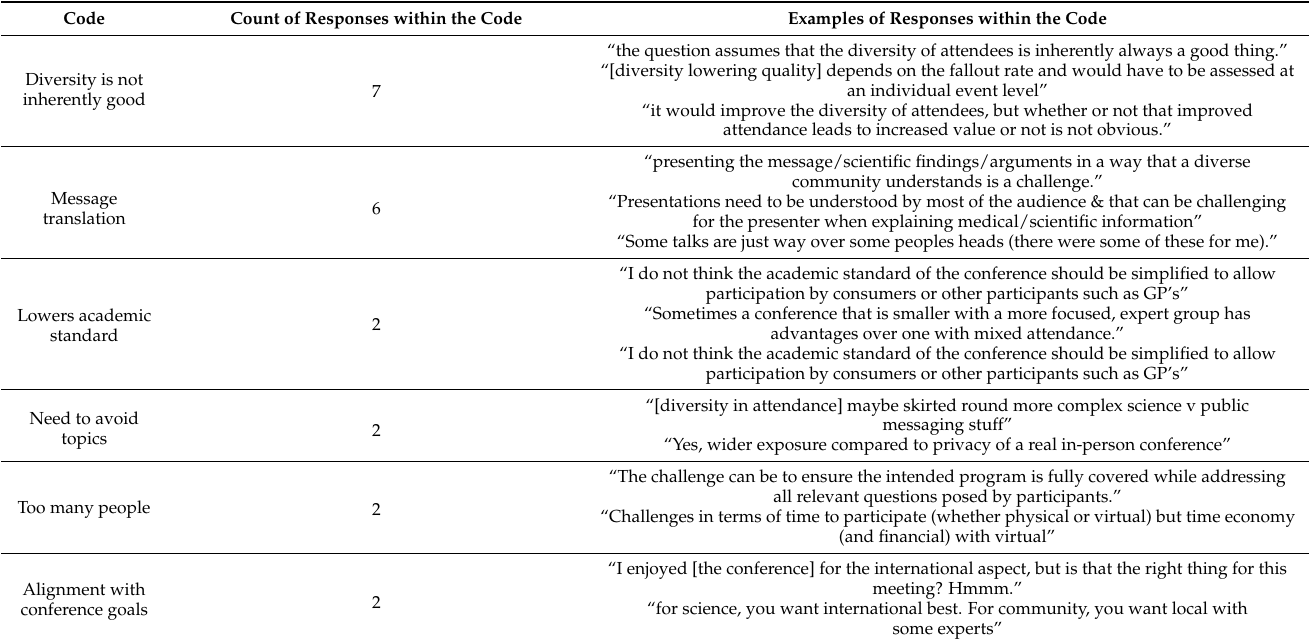
Table 4. Challenges with diverse conference